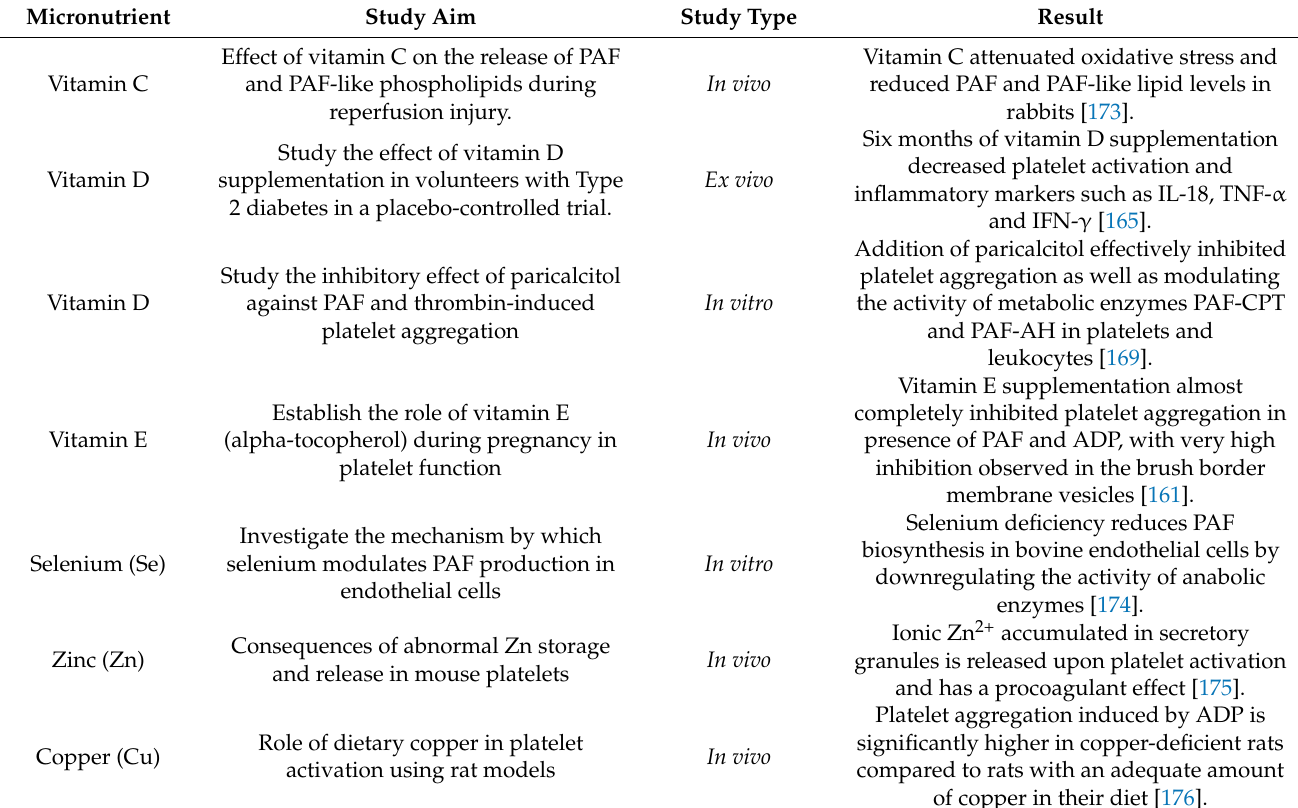
Table 4. Studies investigating the in vitro , in vivo , and ex vivo antiplatelet properties of micronutrients. Micronutrient Study Aim Study